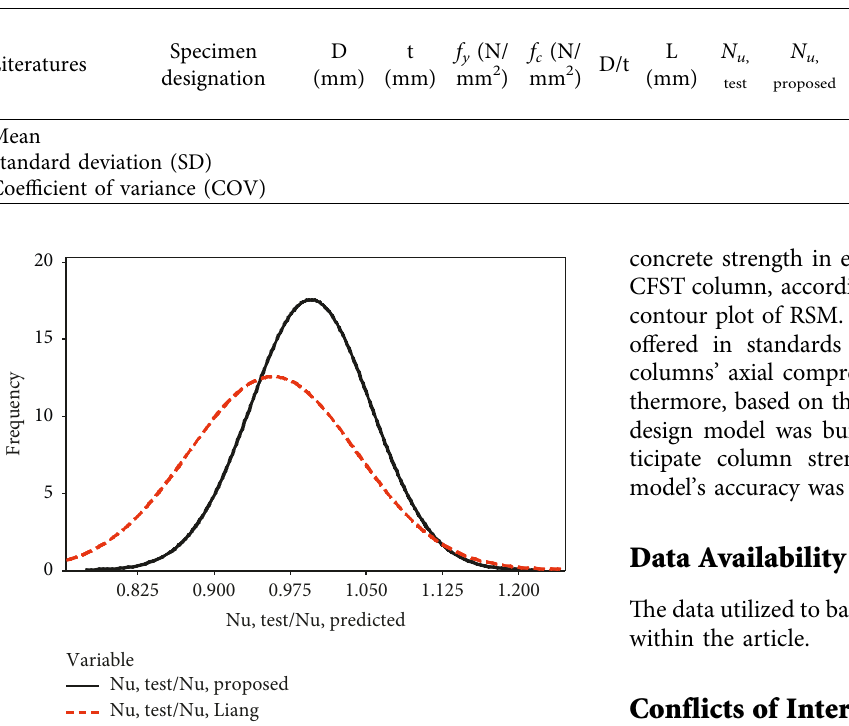
Figure 12: Validation of proposed model with 105 column test results available in various studies: Histogram